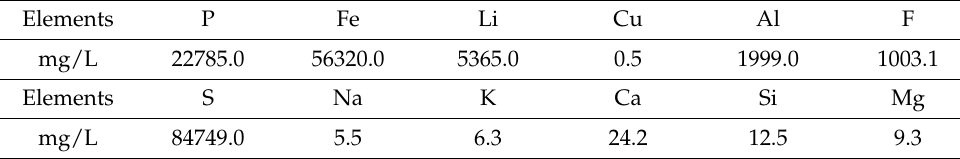
Table 2. Chemical composition of the sulfuric acid